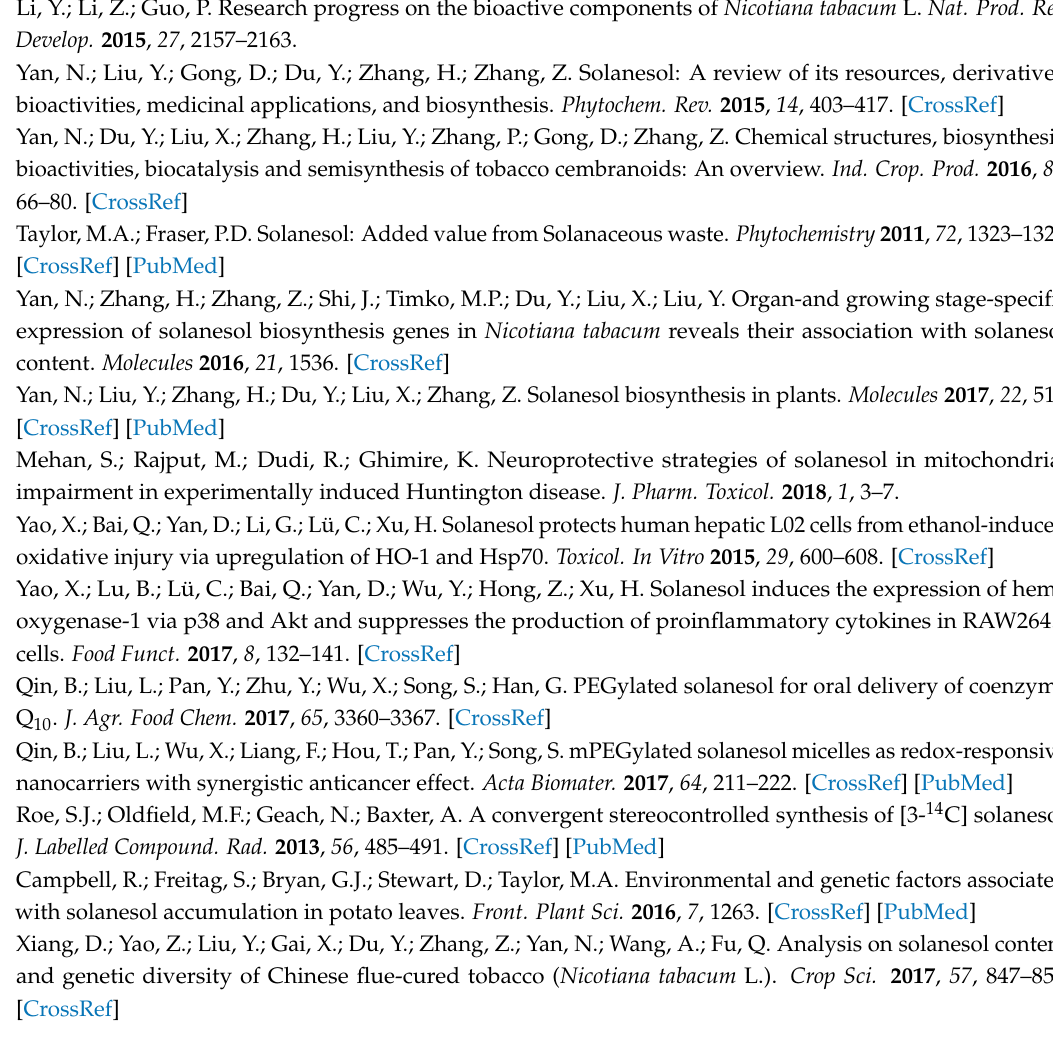
Table S1: Summary of sequencing results of transcriptome of tobacco leaves grown at normal temperature (NT) and moderately high temperature (MHT), Table S2: Sequence alignment results of reads generated from tobacco leaves grown at normal temperature (NT) and moderately high temperature (MHT) mapped to the reference genome, Table S3: The FPKM values of 122 TFs of DEGs between NT and MHT exposed tobacco leaves. Author Contributions: N.Y. conceived and designed the experiments. N.Y. and Y.L. performed the experiments and drafted the manuscript. N.Y., Y.D., H.Z., Z.Z., X.L., J.S., and Y.L. analyzed the data. Funding: This research was funded by the National Natural Science Foundation of China (no.